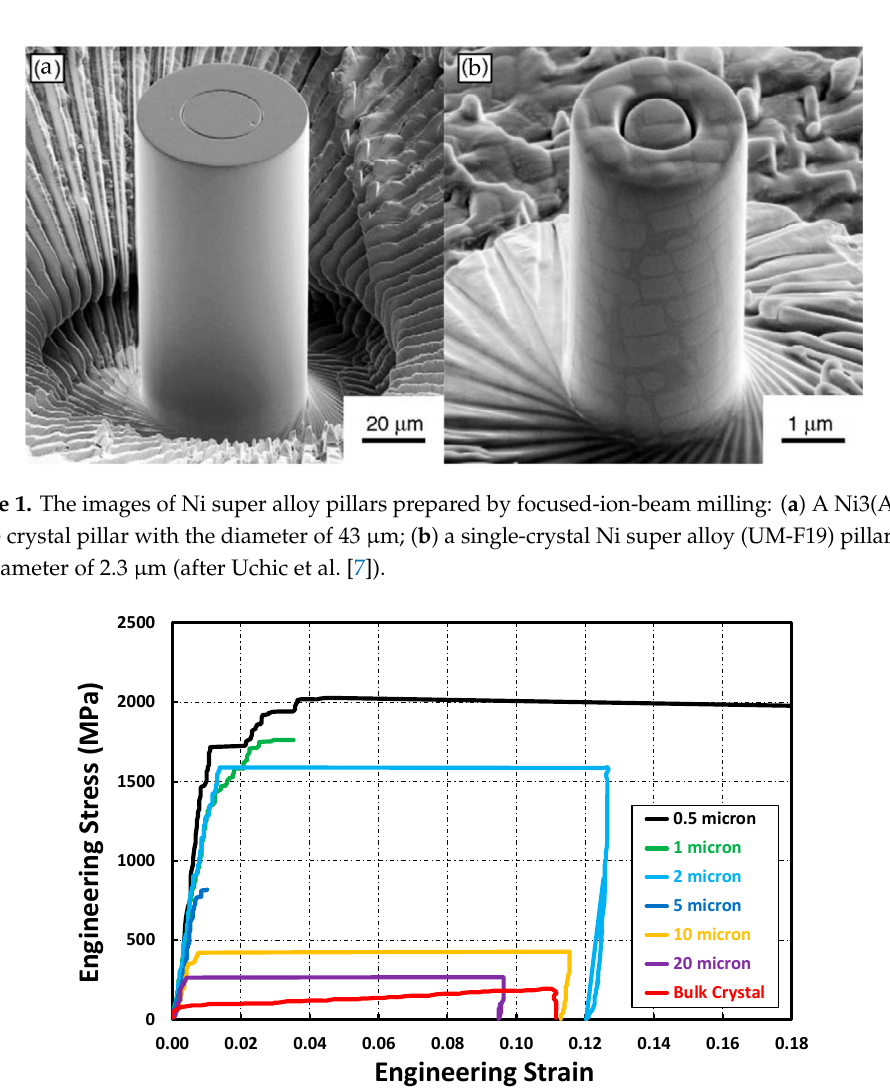
Figure 2. Stress–strain curves of bulk and micron sized Ni3Al-Ta pillars under uniaxial compression at room temperature (after Uchic et al. [9]).